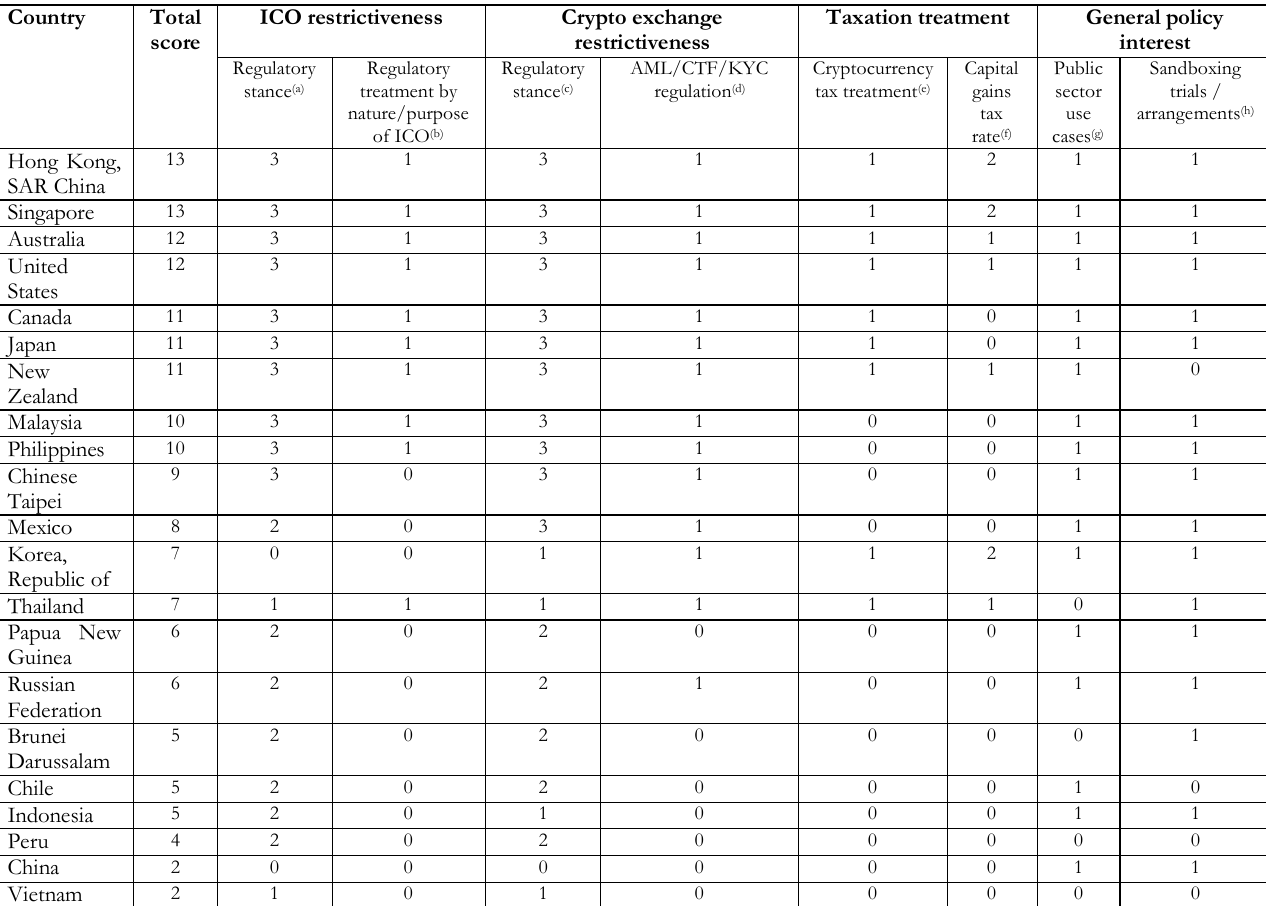
Table I: Crypto-friendly index results for APEC member-states (information as at October